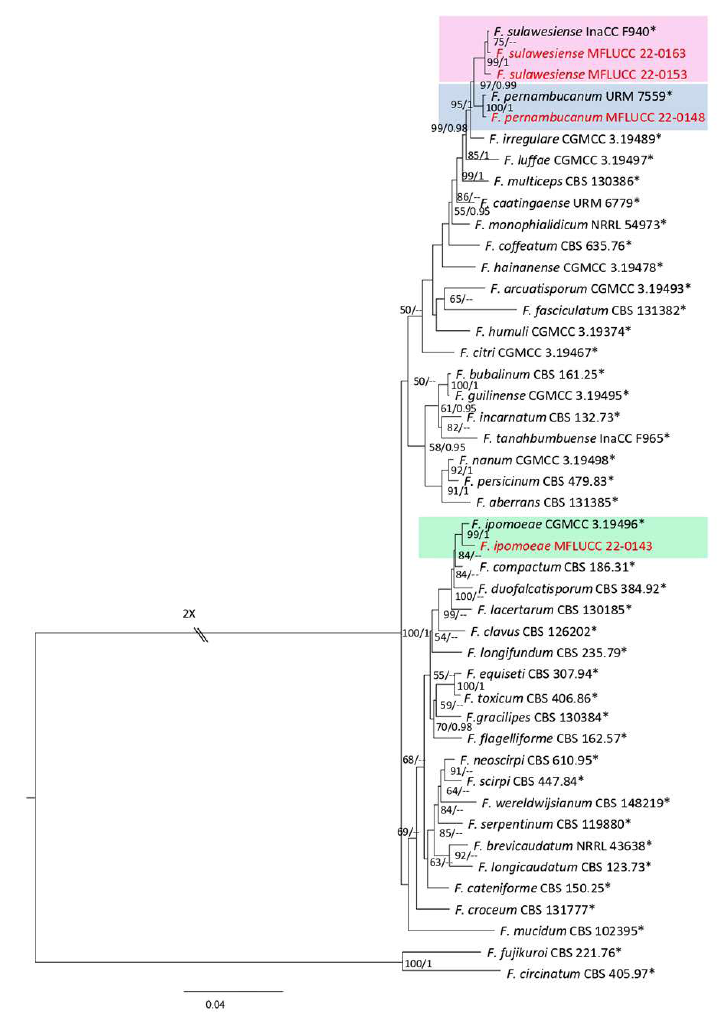
Figure 33. Fusarium incarnatum complex. Bayesian phylogenetic tree obtained from the combined tef1 , rpb1 , and rpb2 sequence data. The ultrafast maximum likelihood bootstrap support (%) ≥ 50 and BYPP ≥ 0.95 are shown at the nodes. The ex-type strains are marked with an asterisk. The tree is rooted in F. fujikuroi (CBS 221.76) and F. circinatum (CBS 405.97).